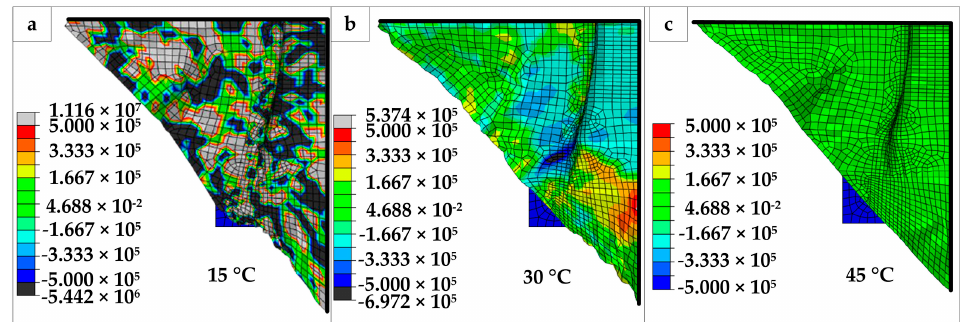
Figure 15. Schematic diagram of stamping device and simulation.